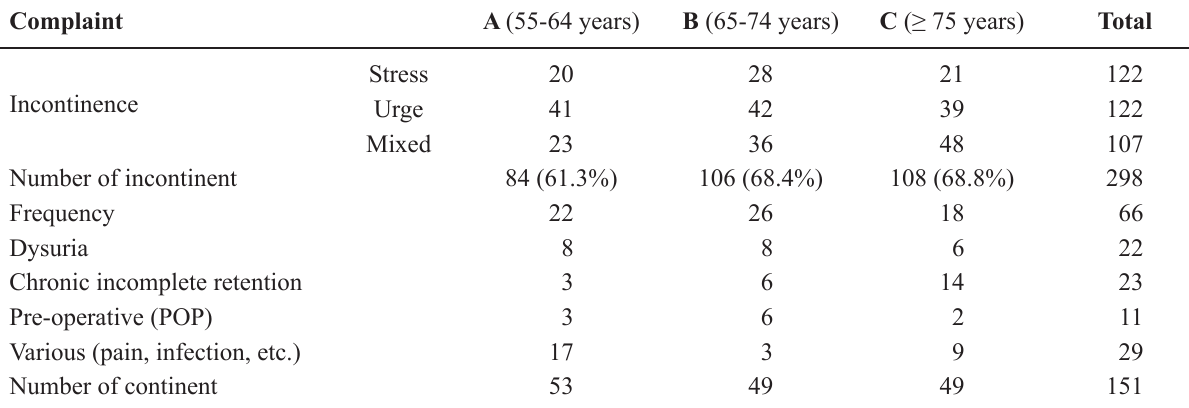
Table 1 – Motive for urodynamics. POP = pelvic organ